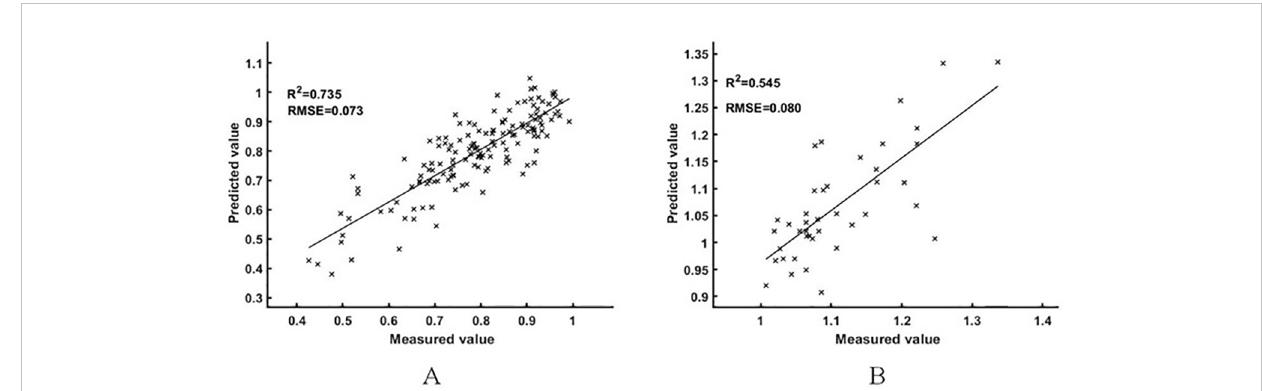
FIGURE 9 Different N nutrient index intervals [ (A) for the N-de fi cient group, (B) for the N-rich group].